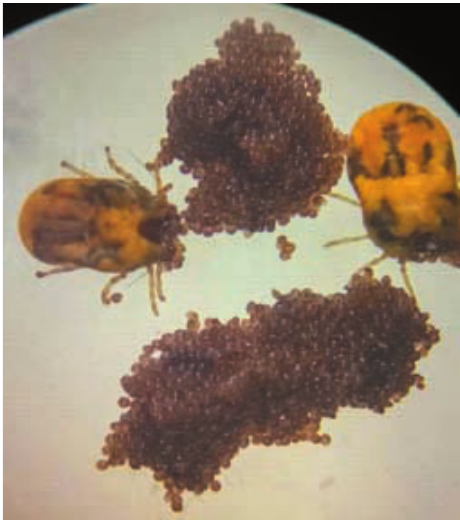
Fig. 1 Egg mass of R. (B.)